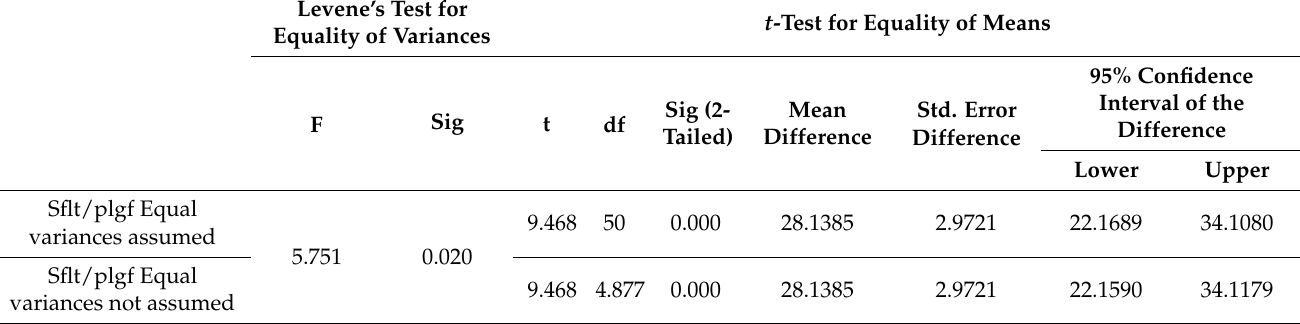
Table 3. Independent t -test for severe PE and moderate PE.